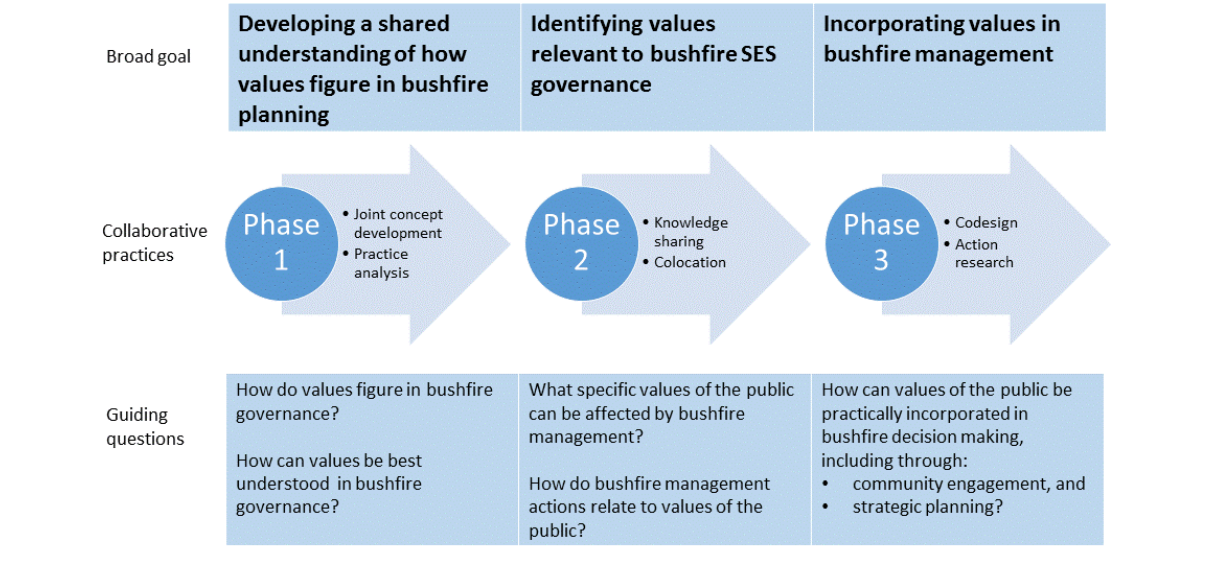
Fig. 4. Summary of research collaboration across 2015–2017, indicating broad goals, collaborative practices, and guiding questions.